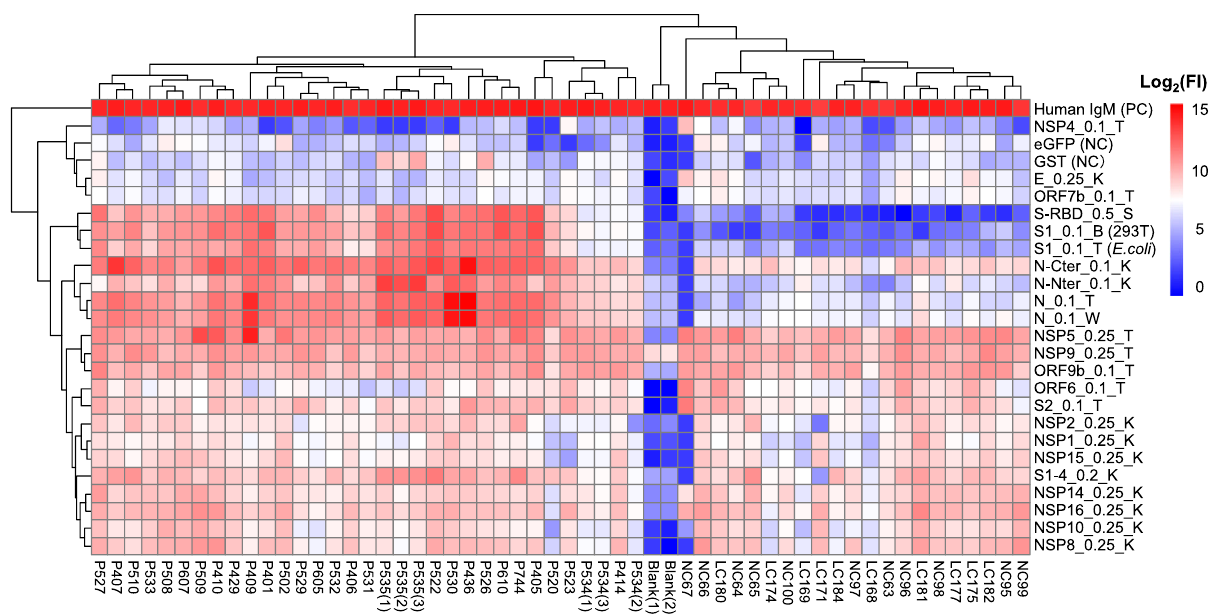
Fig. 4 The overall SARS-CoV-2-speci fi c IgM pro fi les of the 29 convalescent sera against the proteins. Each square indicates the IgM antibody response against the protein (row) in the serum (column). The rest was the same as that of Fig.